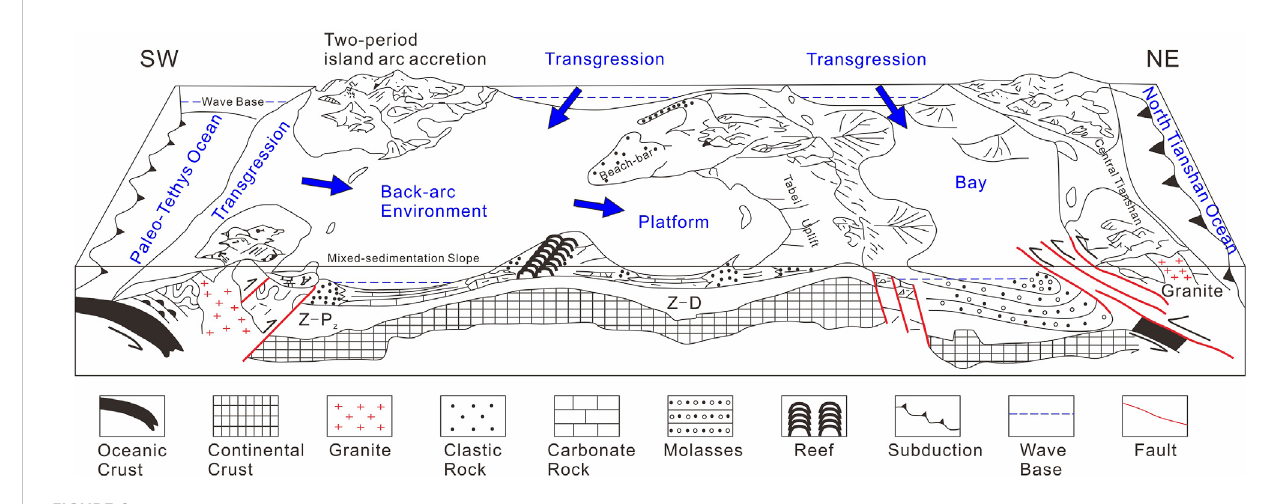
FIGURE 8 Carboniferous-Permian proto-type basin con fi guration in Tarim basin (modi fi ed according to He et al., 1992; Gong, 2010; Zhou et al.,